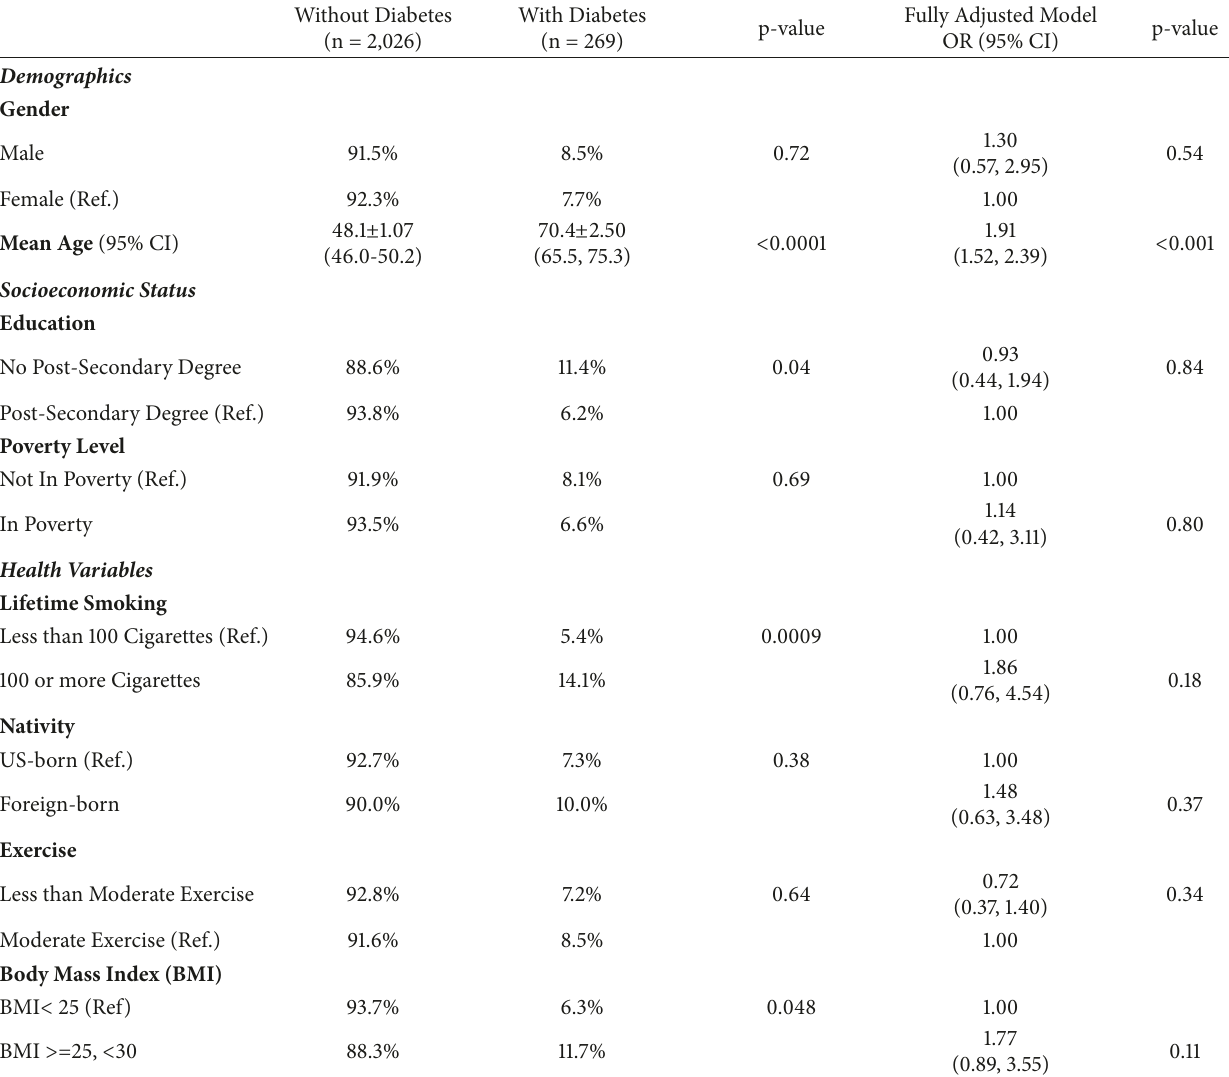
Table 2: Descriptive characteristics and odds of having diabetes (OR) of nonobese Japanese-American adults with and without diabetes